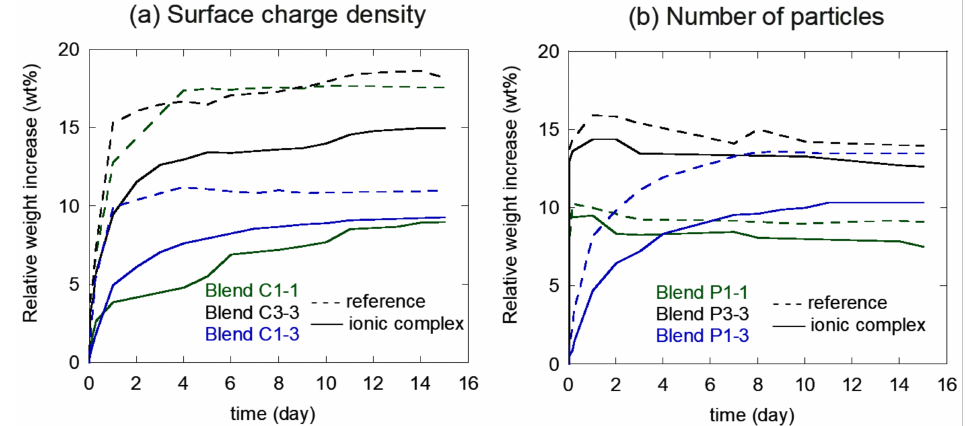
Figure 8. Evolution of water uptake by the blend films ( a ) based on equal surface charge density; and ( b ) based on equal number of